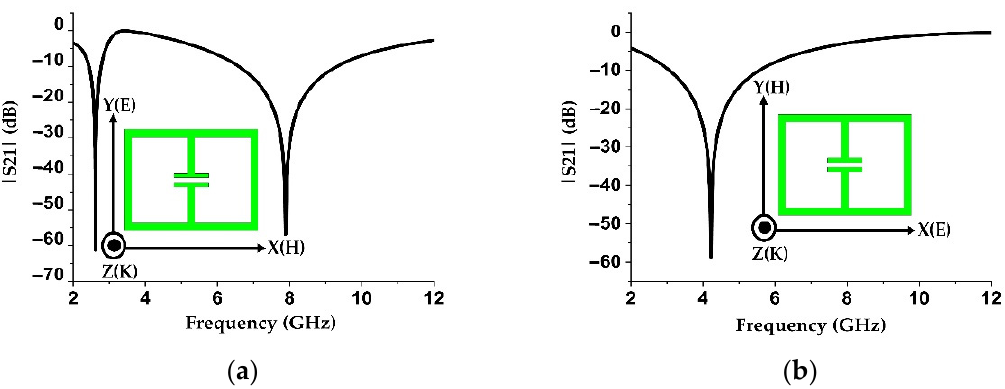
Figure 4. S21 spectrum of the ELC resonator for ( a ) Setup 1 and ( b ) Setup 2.